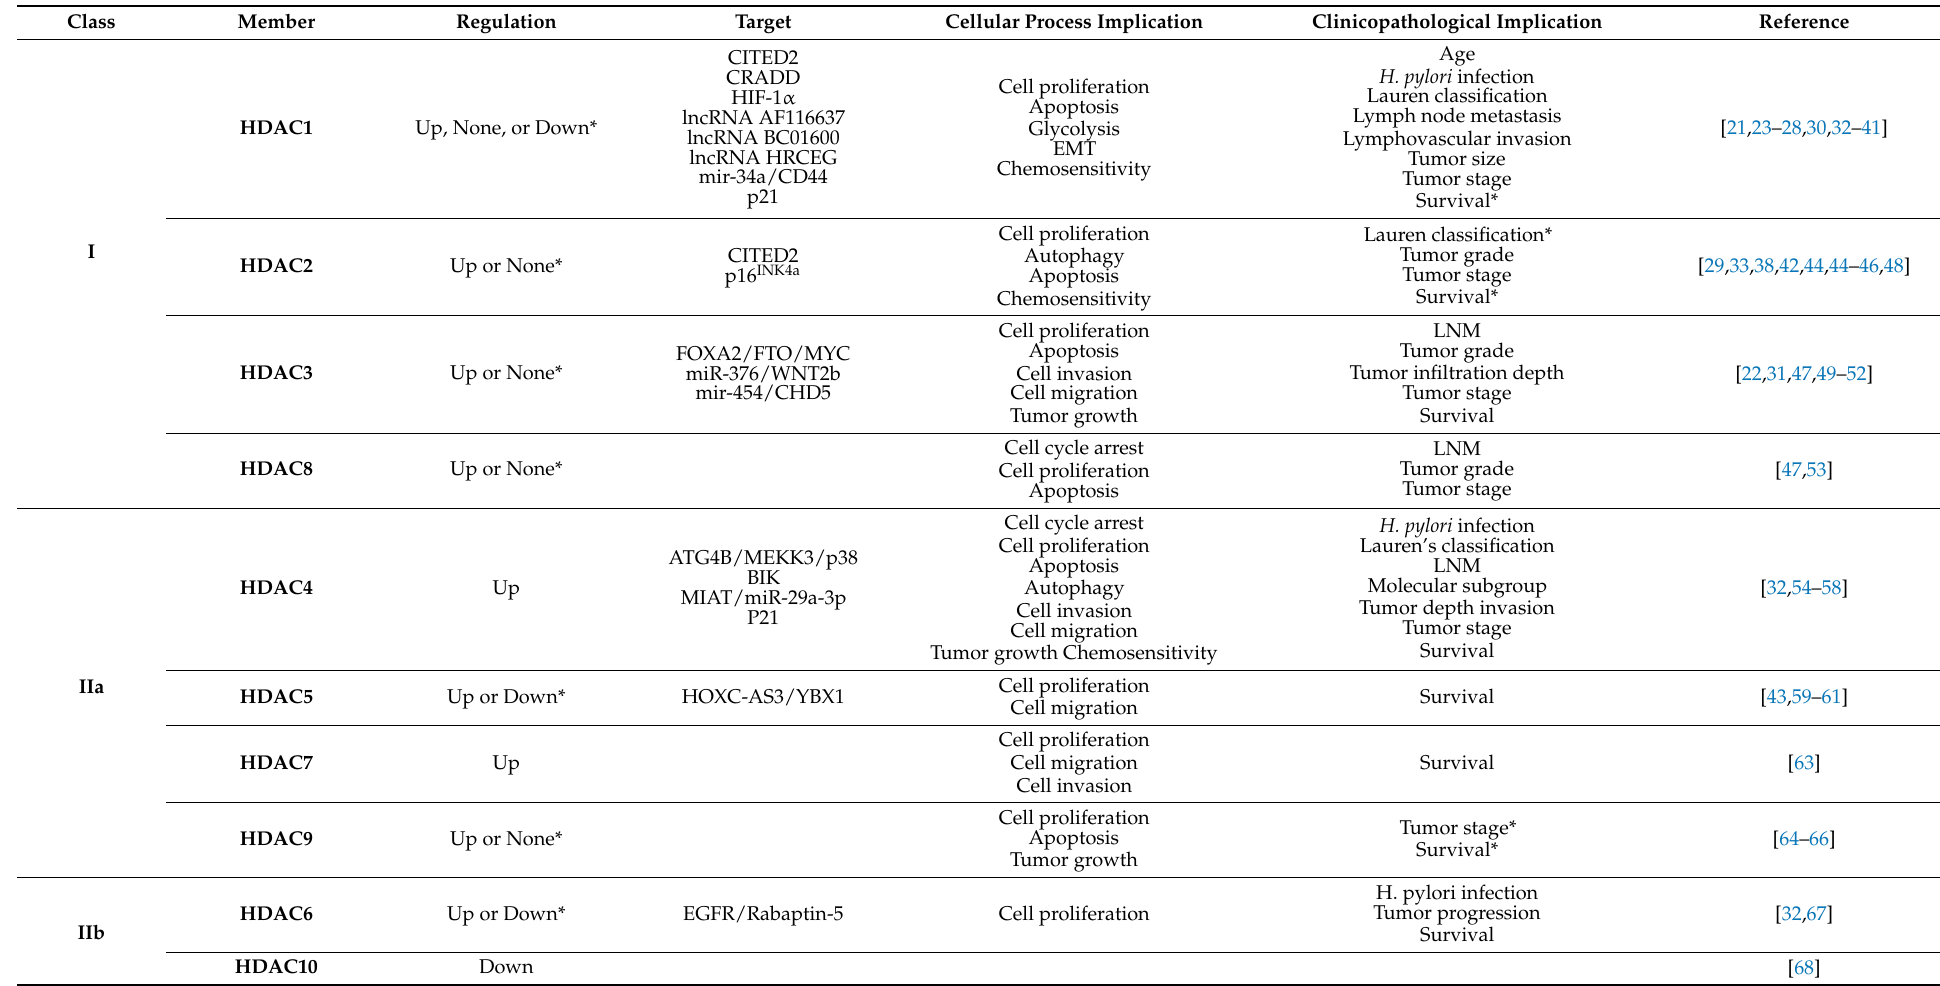
Table 2. Summary of HDAC regulations, targets, cellular process, and clinicopathological implications in GC.